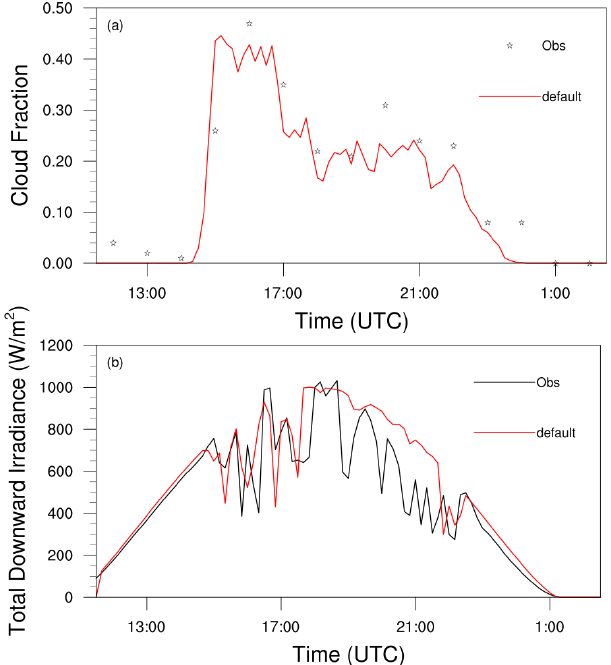
Figure 2. Time series of (a) domain-averaged cloud fraction and (b) total downward irradiance at the central point from the observa- tion and the default experiment in the cumulus case.